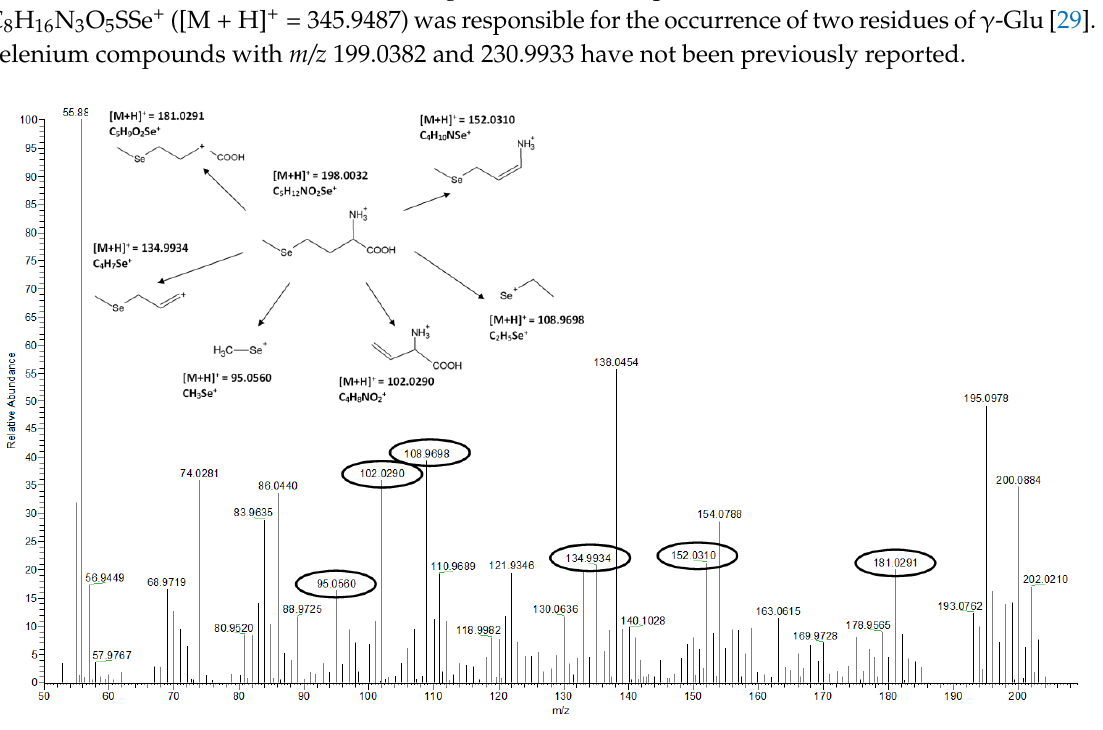
Figure 4. Fragmentation spectrum for ion with m / z = 198.0032 and fragmentation pathway.